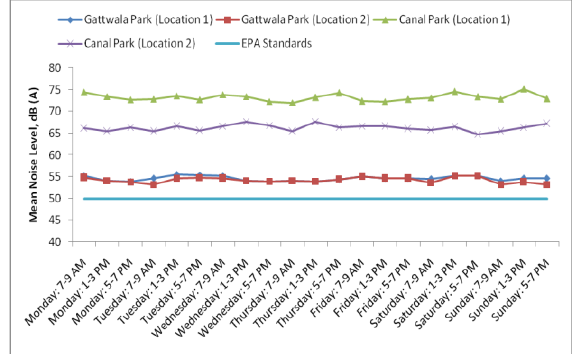
Figure 5: Comparison of Average Noise Level of both sites against EPA Standard